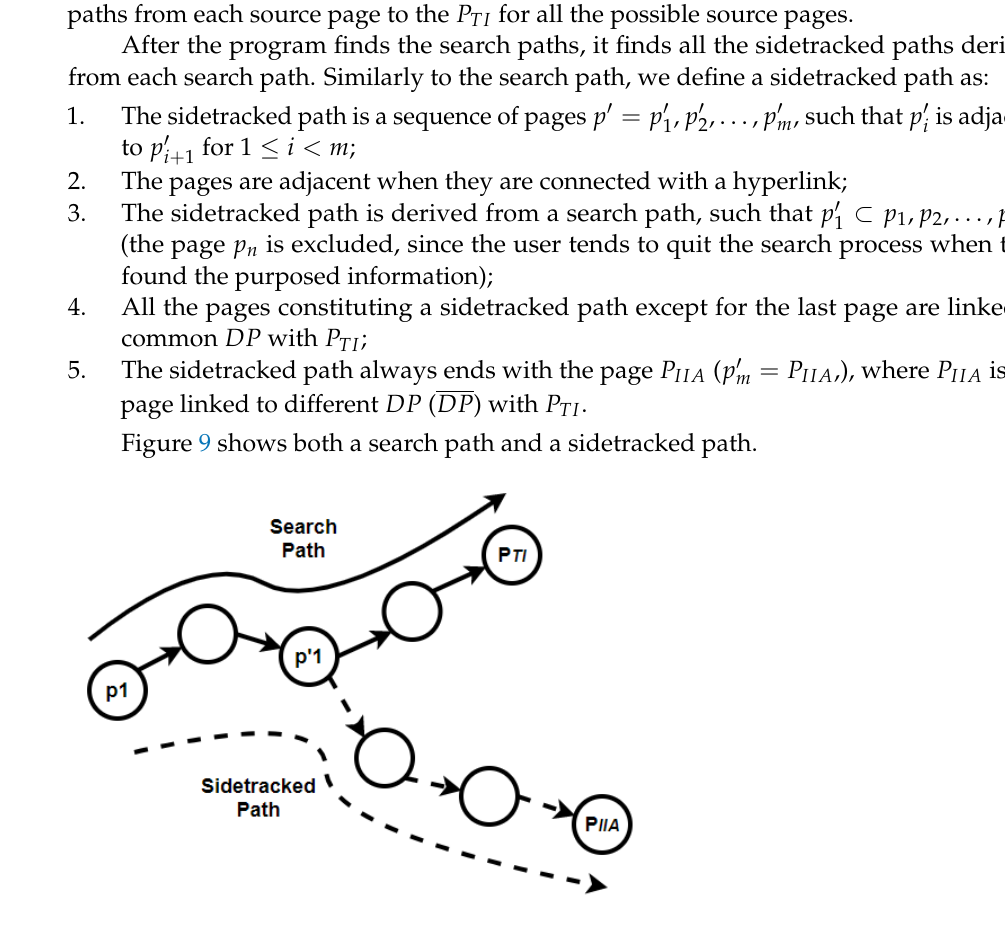
Figure 9. A search path and a sidetracked path. For all (search path, sidetracked path) pairs on the information space, the serendipity value is measured with a metric proposed in Section 3.2.4. The program aggregates the measured values to compute the whole information space’s potential serendipity value as a final